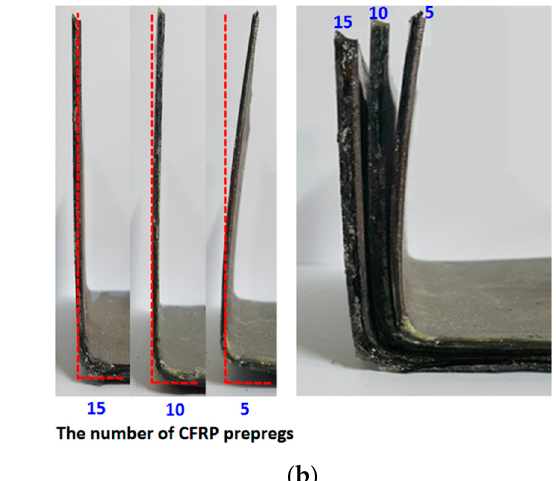
Figure 3. Formed hybrid composites through V-bending test: ( a ) CFRP/CR980; ( b ) CR980/CFRP.